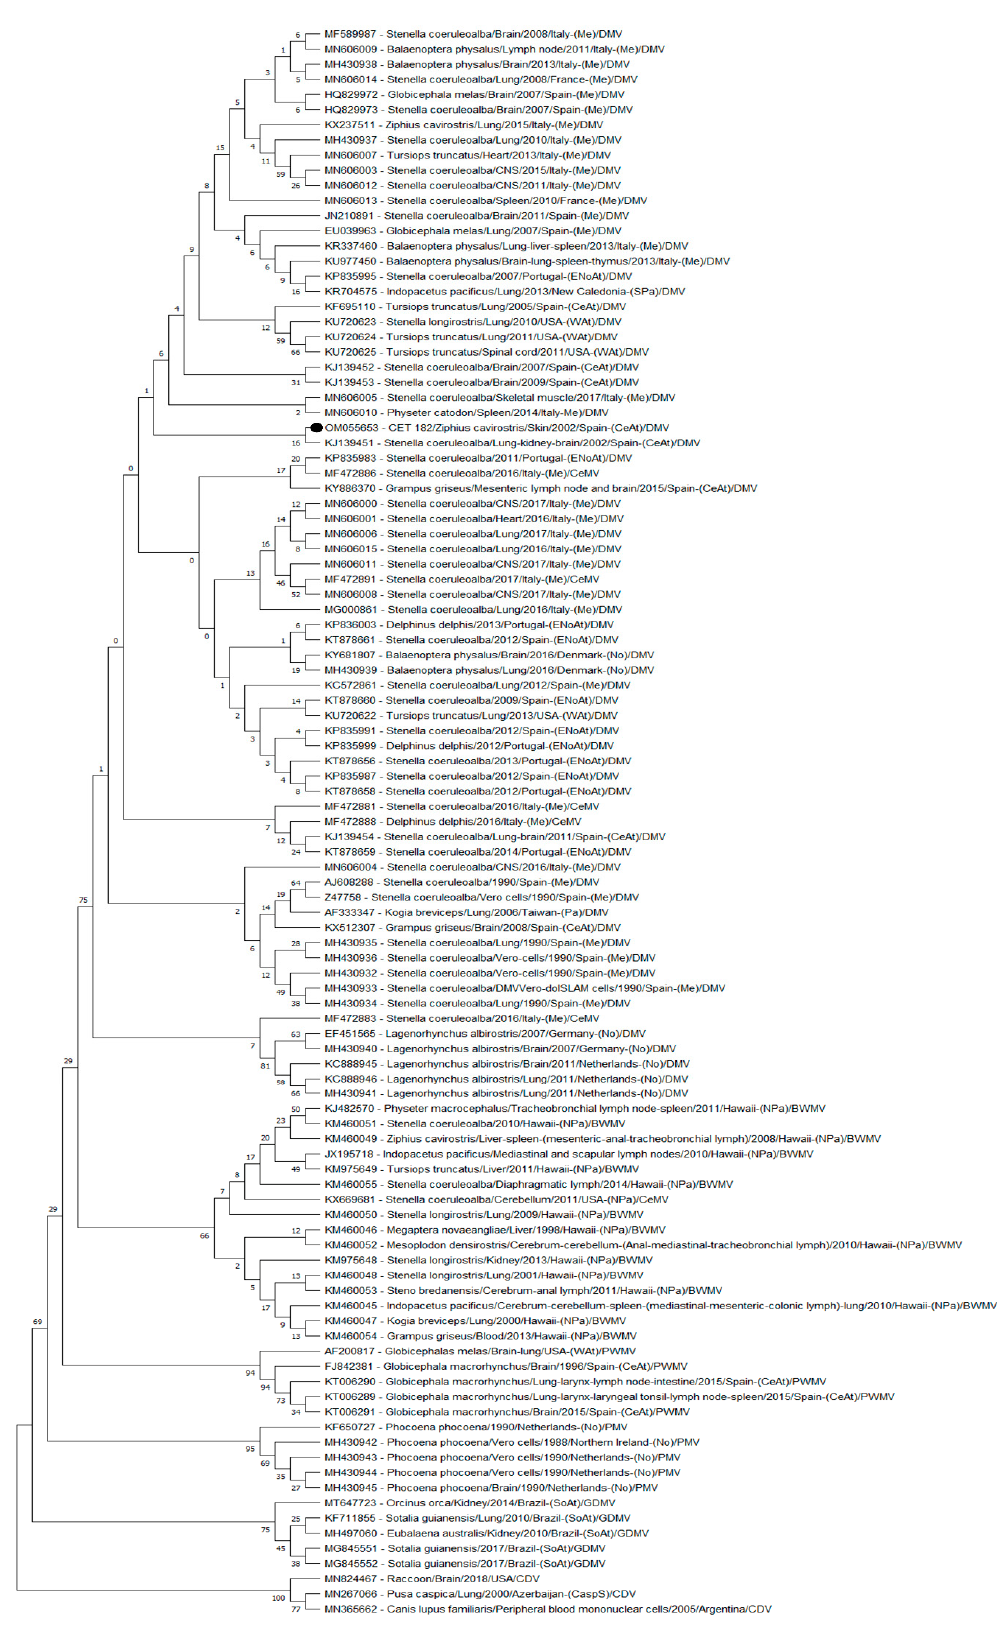
Figure 2. Maximum likelihood phylogenetic tree for the nucleotide sequences of the phosphoprotein (P) gene. The phylogenetic tree consists of 102 sequences from reported cases of cetacean